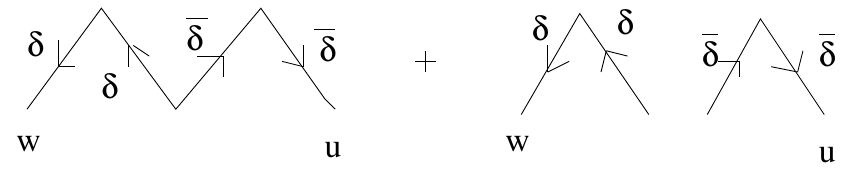
Figure 9 . Skeleton graphs for (cid:8) 2 ;E .